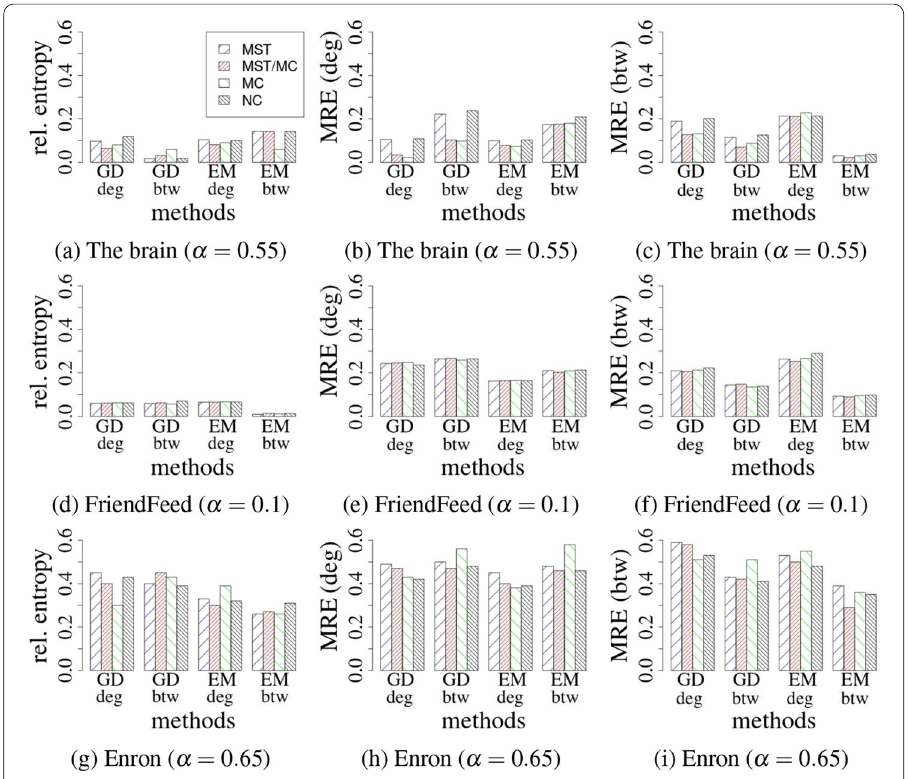
Fig. 6 Impact of density and backboning methods on sparsification–real data: Relative entropy (column one), mean relative error of expected degree (column two) and mean relative error of expected ego betweenness (column three) after sparsification of a – c the brain network with α = 0.55 , d – f the FriendFeed network with α = 0.1 , and g – i the Enron network with α = 0.65 . In the MST/MC backboning method α ′ = 0.5